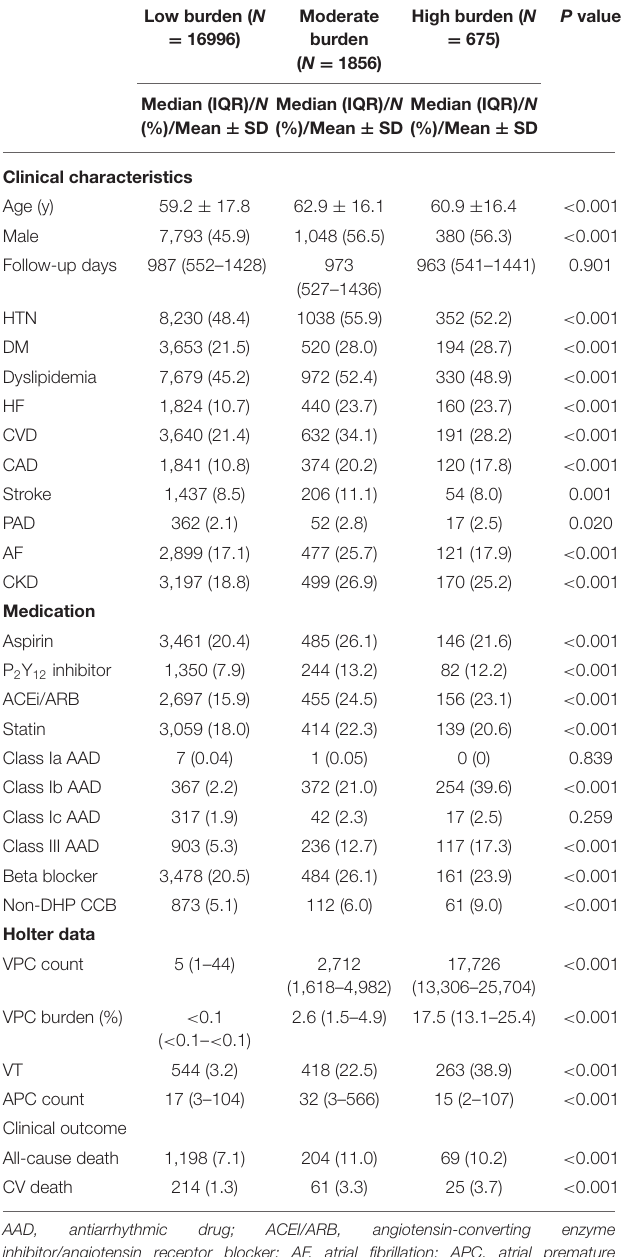
TABLE 1 | Baseline characteristics, medication history, Holter data, and clinical outcome based on different VPC